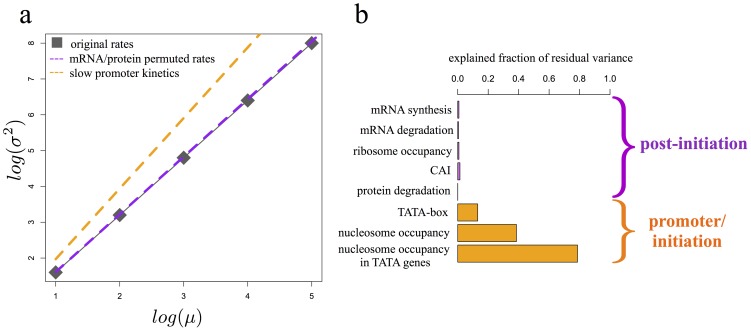
Promoter kinetics but not mRNA and protein synthesis and degradation rates modulate the relationship between mean and variance.a) Predicted relationship between mean and variance using original model with original parameter set (grey squares), original model with permuted sets of kinetic rates for mRNA/protein synthesis and degradation (purple), and slow promoter kinetics model with original parameter set (orange). b) Fraction of residual variance explained (r2) by sources of noise operating at the promoter/initiation level (orange) or at a post-initiation level (purple).